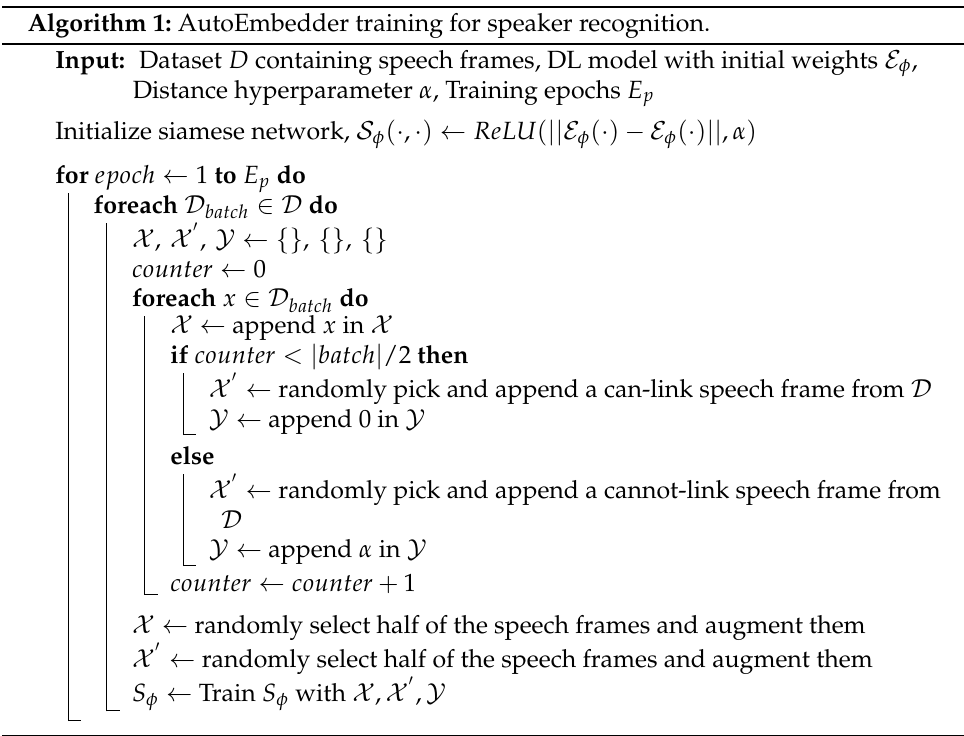
Algorithm 1: AutoEmbedder training for speaker